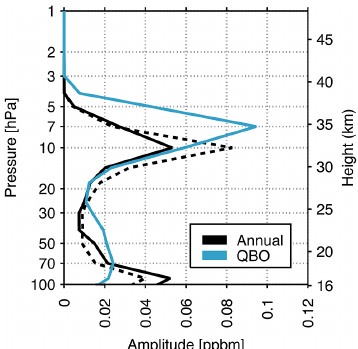
Figure 4. Comparison of the approximate peak-to-peak amplitudes of the annual cycle and the QBO in the simulated aerosol mixing ratio of the QBO-nudged model (straight lines), and the of the con- trol simulation CTL without a QBO (dashed line). All data averaged between 5 ◦ N and 5 ◦ S for the years 1996–2006. The peak-to-peak amplitude of the QBO is estimated following Baldwin and Gray (2005). The peak-to-peak amplitude of the annual variation refers to difference between the maximum and the minimum of the calcu- lated climatological mean annual